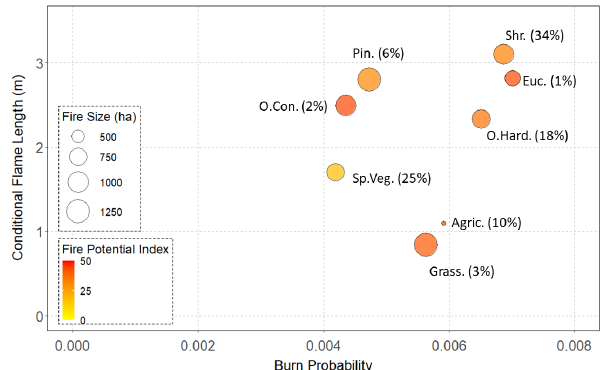
Figure 6. Averaged values of simulated burn probability (BP), con- ditional flame length (CFL), fire size (FS) and fire potential in- dex (FPI) for the eight main land cover classes in the study area. The percentage of each class burned is shown in parenthesis. Bub- ble size is proportional to FS, and the color represents the FPI values. Agric.: agriculture; Pin.: maritime pine; Euc.: eucalypt; Sp. Veg.: sparse vegetation; O. Con.: other coniferous; Shr.: shrub- lands; Grass.: grasslands; O. Hard.: other